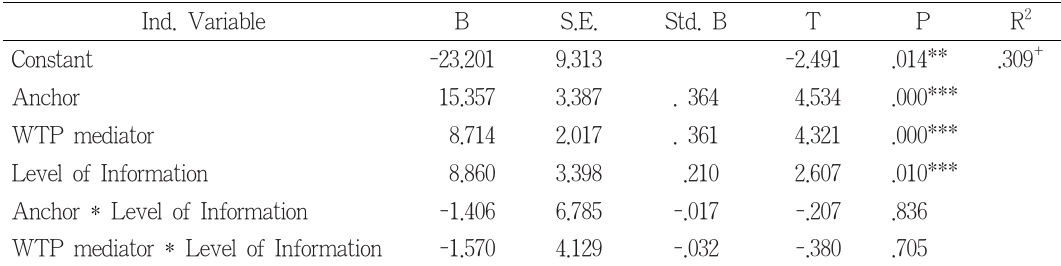
<Table 4> Interaction Effect of Information Level on WTP